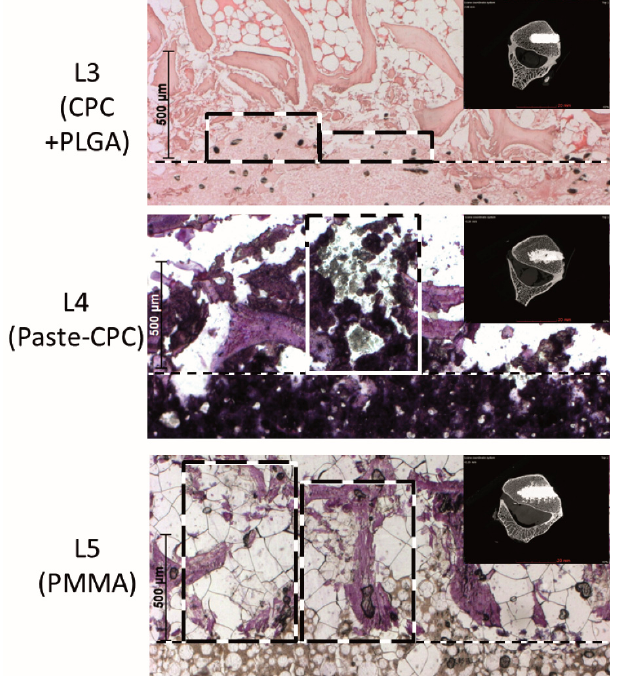
Figure 4. Eosin/hematoxylin ( top ) or hematoxylin staining ( middle and bottom ) of representative sections demonstrating the extrusion of CPC + PLGA fibers ( top ), Paste-CPC ( middle ), and PMMA bone cement ( bottom ) into the spongiosa of the ex vivo injected vertebral bodies; inserts display the corresponding micro-computed tomography images; the original defect edge is marked by the dashed line; boxes with dashed lines illustrate regions of cement extrusion, scale bars the distance from the defect edge (500 µ m); CPC, calcium phosphate cement; PLGA, poly(L-lactide-co-glycolide); PMMA, polymethylmethacrylate.